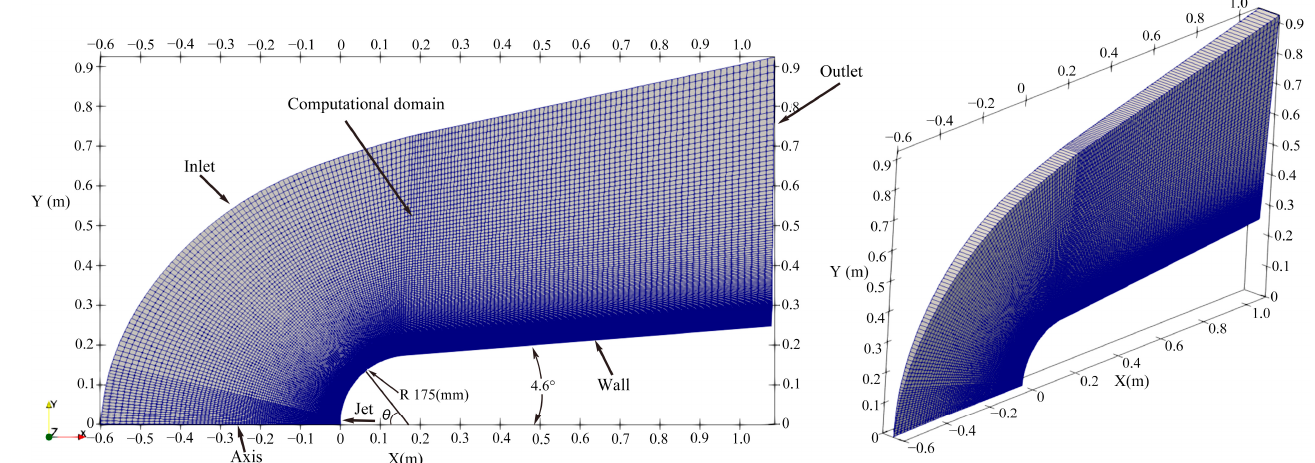
Figure 1. Grid and geometric model.